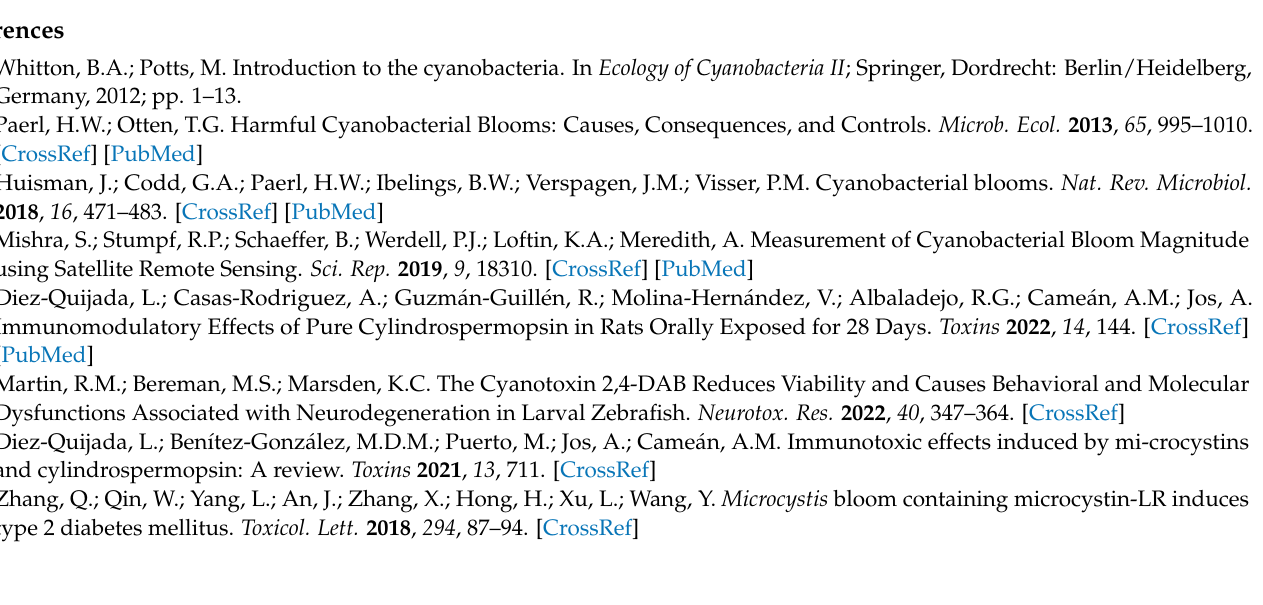
Figure 6. Genome comparison of the Microcystis cyanophage Mae-Yong1326-1, MinS1, and Mwe- Figure 6. Yong1112-1. and Table 3. Genome-characteristics of Microcystis cyanophages Mae-Yong1326-1, MinS1, Mwe- Yong1112-1, and Mwes-Yong2.